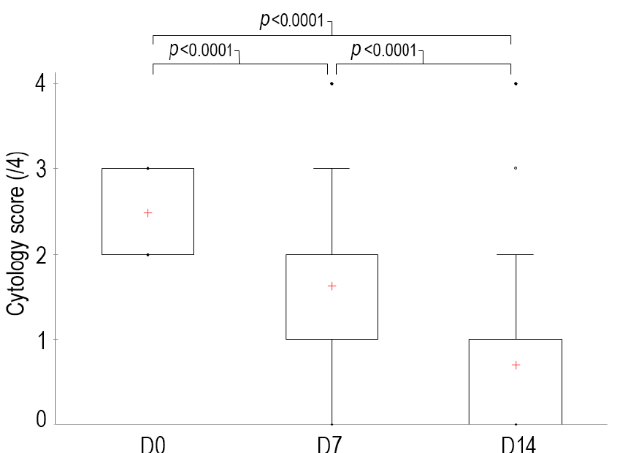
Figure 1. Kinetics of the global cytology score in dogs with erythemato-ceruminous otitis externa whose ears were cleaned with the tested ear cleanser at different time points during the study. Interpretation of the box and whiskers plots: the top of the reach box represents the third quartile, the red cross (+) in the middle is the mean, the bottom of the box is the first quartile and the upper and lower whiskers represent the minimum and maximum scores. Dots were considered as outliers.